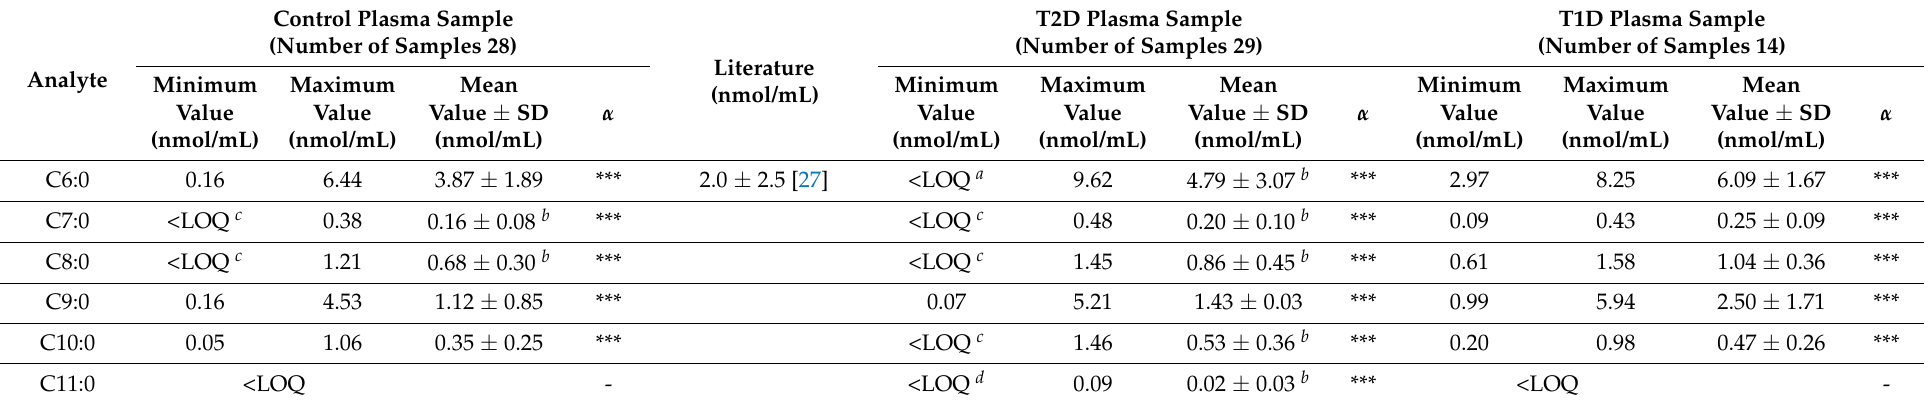
Table 3. Contents of FFAs in plasma samples